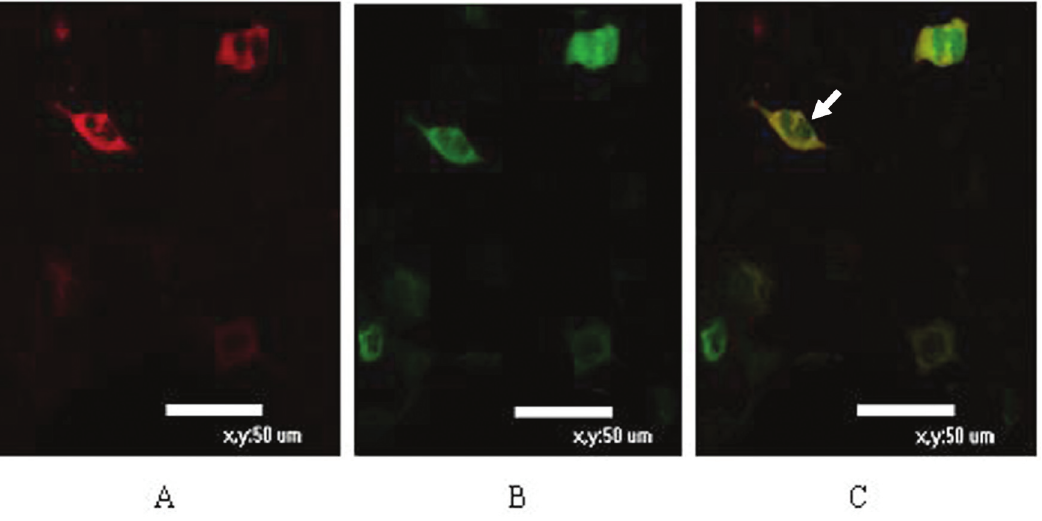
Figure 2. Immunofluorescent co-localization test. A , pDsRed/ATP1B1 localized in the cell membrane; B , the pEGFP/ UL136 fusion protein localized in both the cell membrane and cytoplasm; C , confocal microscopic analysis revealed that UL136 fusion protein co-localized with ATP1B1 fusion protein in mammalian cells on the